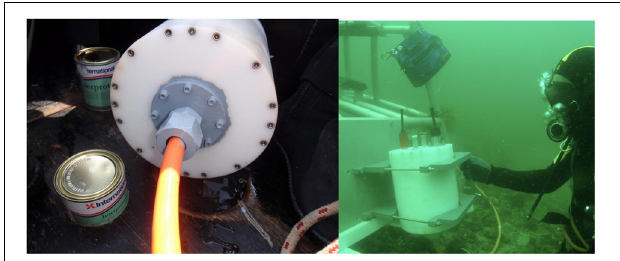
FIGURE 4 | Left: Sea cable feedthrough coated with corrosion protection. Right: Breakout box mounted on the frame of the Helgoland underwater node system. Photos: P. Fischer.